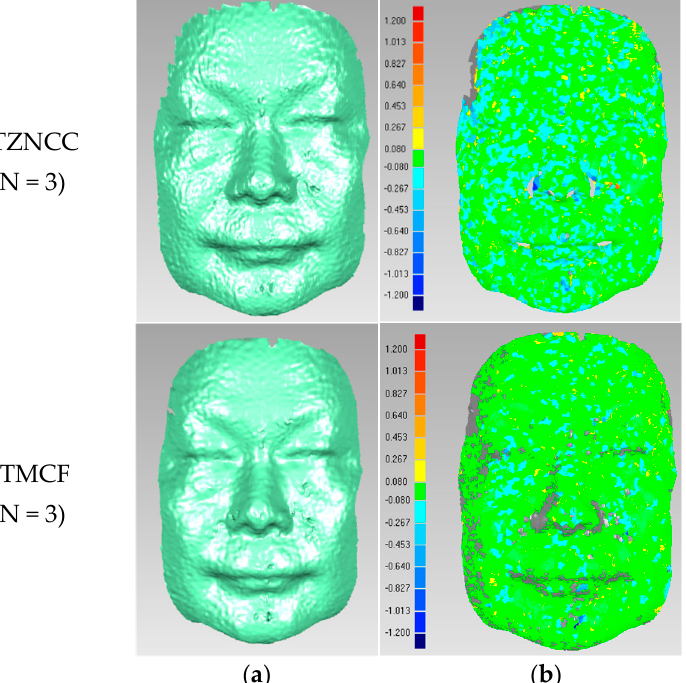
Figure 8. ( a ) 3D reconstruction result of the plastic human face (N = 3); ( b ) Corresponding error distribution map.